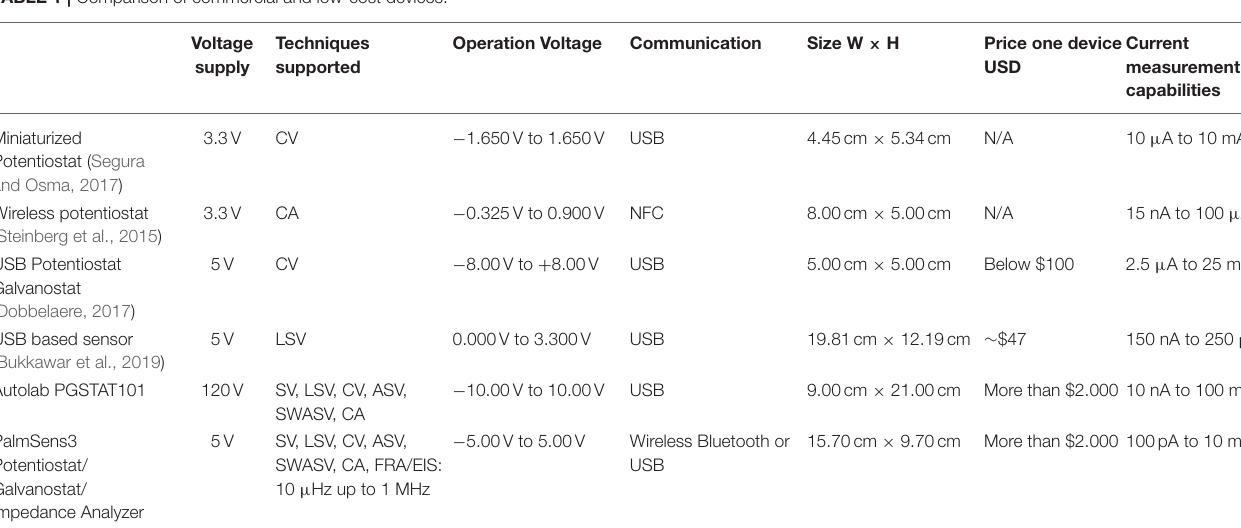
TABLE 1 | Comparison of commercial and low-cost devices. Voltage